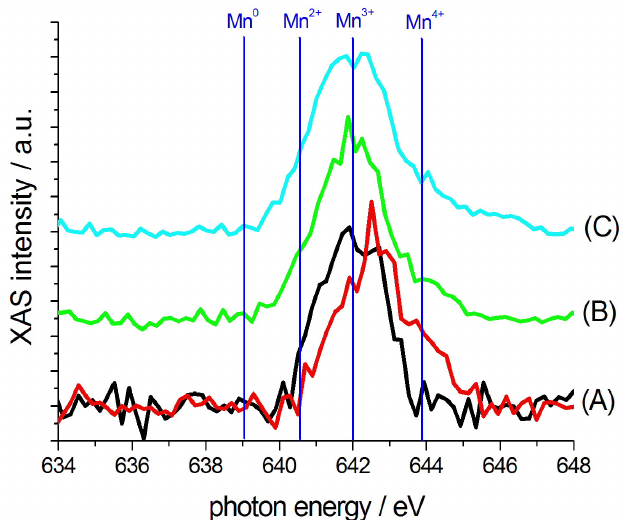
Figure 6. Micro-XAS at the Mn L-edge of electrodeposited Mn-based/PPy composites: ( A ) Mn–Co–Cu/PPy (red plot: high-Cu zones); ( B ) Mn–Co–Mg/PPy; ( C )